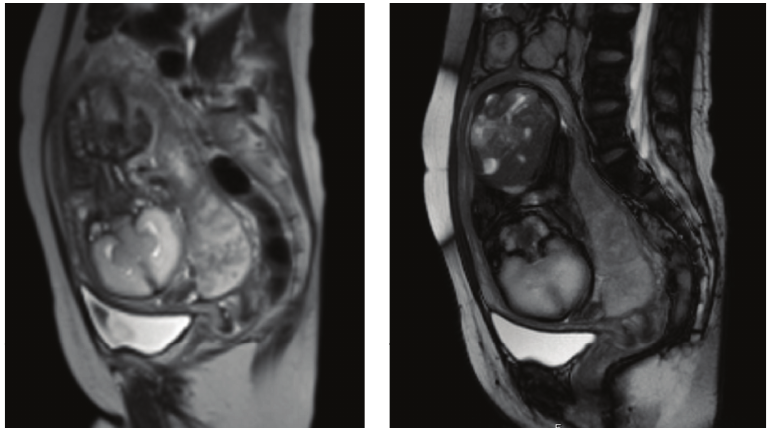
Figure 1: Partial placenta previa, severe oligohydramnios, and holoprosencephaly (semilobar type) by magnetic resonance imaging (MRI) at 32 weeks of gestation.